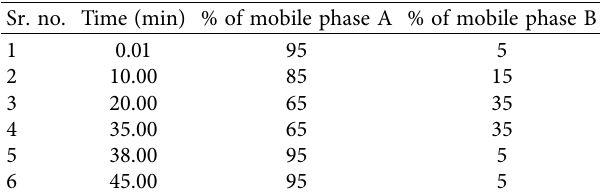
Table 2: Gradient